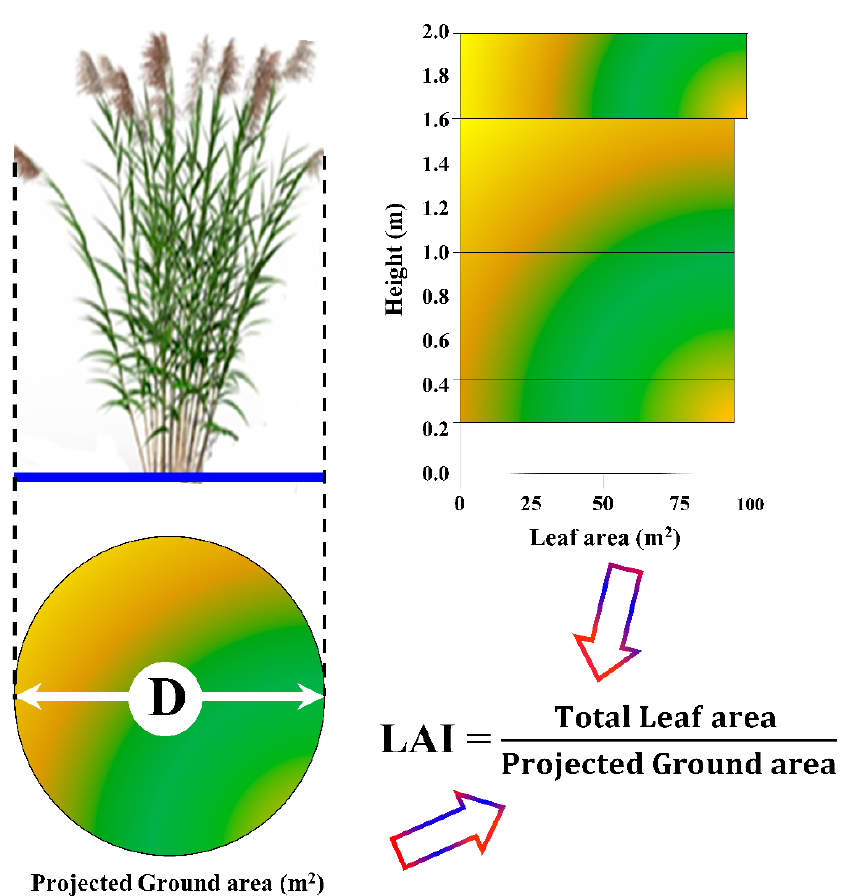
Figure 6. Vertical distribution of riverine vegetation’s leaf area for 2 m high plants (green-yellow rectangles) and corresponding leaf area index (LAI) in the case of the riverine vegetation species identified along the Morra Creek: Phragmites australis (Cav.) Trin. Ex. Steudel. (common reed stands); D (m) is the average diameter of the “Projected ground area” (m 2 ).